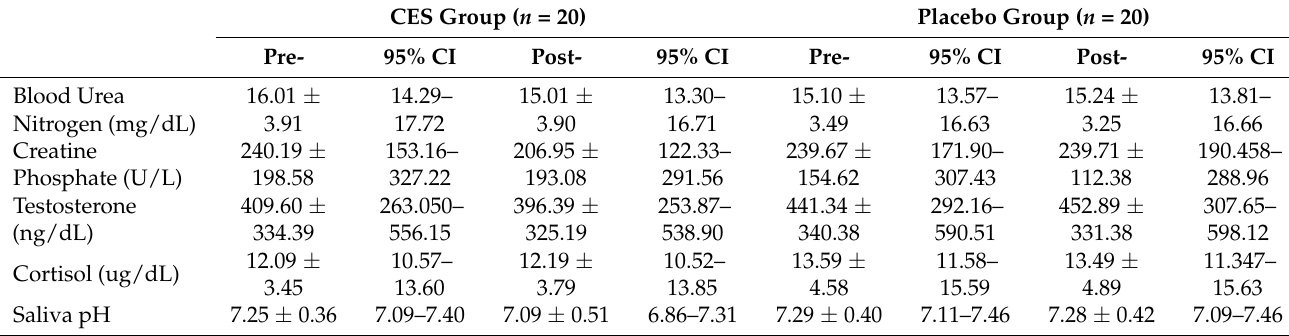
Table 2. Outcomes of biochemistry analysis of the two